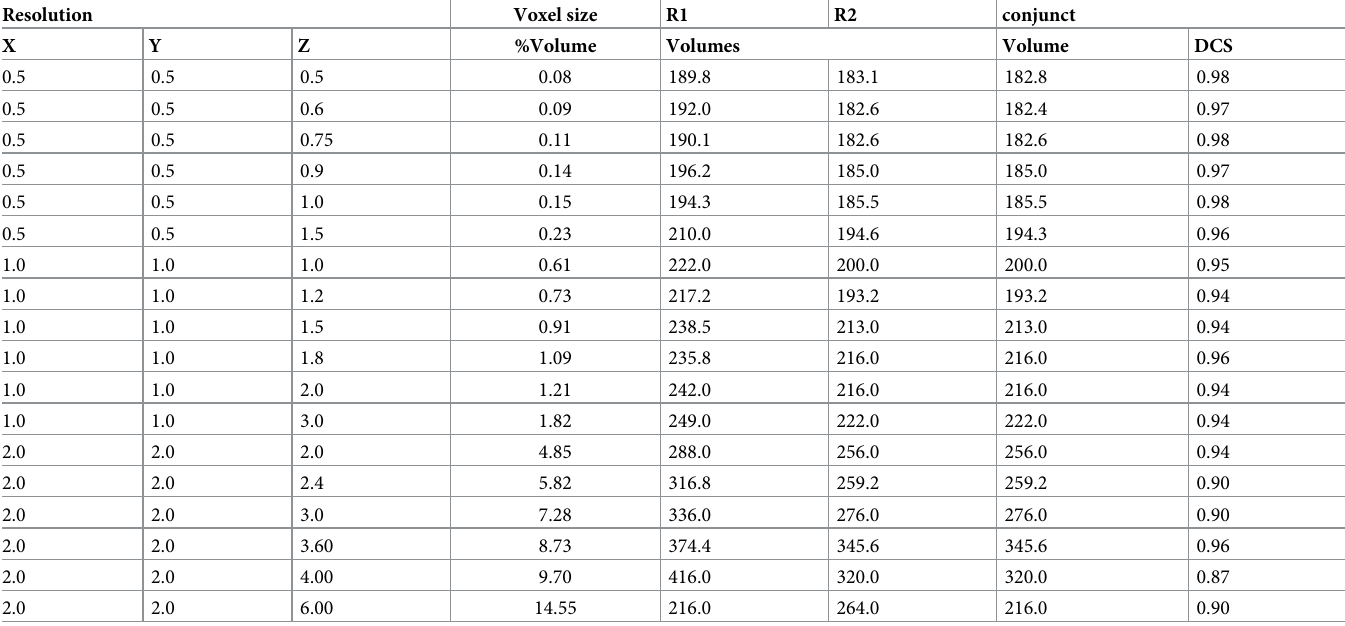
Table 2. Mask volumes for rater 1 and 2 (R1 and R2) and their conjunct mask. Labeled volumes were oriented diagonal to the slice axes and were reconstructed from one simulated ellipsoid at different resolutions (x, y, z). Voxel size indicates the fraction of the ground truth volume (164.9mm 3 ) represented by 1 voxel. DCS show a strong overlap ( > 0.87) between the two